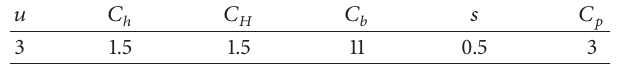
Table 1: Parameter settings of constants for the model.